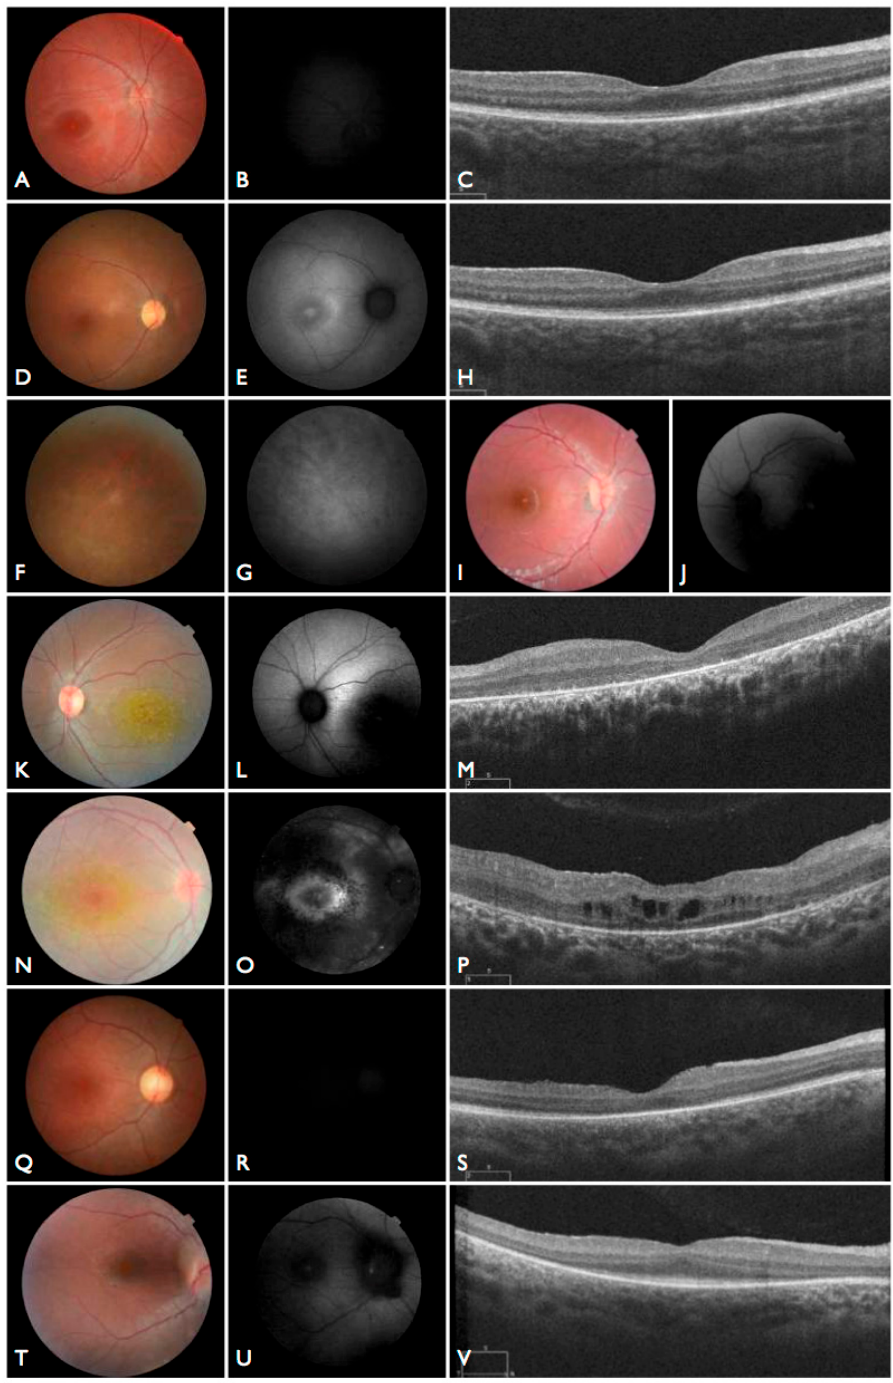
Figure 3. Fundus and optical coherence tomography (OCT) images for seven individuals solved by mutations in canonical LCA-associated genes. ( A – C ) Fundus and OCT images of FBP_ABC solved by mutations in RPE65 . ( D – H ) Fundus and OCT images of FBP_29 solved by mutations in CEP290 . ( I , J ) Fundus images of FBP_4 solved mutations in GUCY2D . ( K – M ) Fundus and OCT images of FBP_34 solved by compound heterozygous mutations in CRB1 . ( N – P ) Fundus and OCT images of FBP_36 solved by mutations in CRB1 . ( Q – S ) Fundus and OCT images of FBP_55 solved by mutations in LRAT . ( T – V ) Fundus and OCT images of FBP_62 solved by a homozygous mutation in CEP2 .